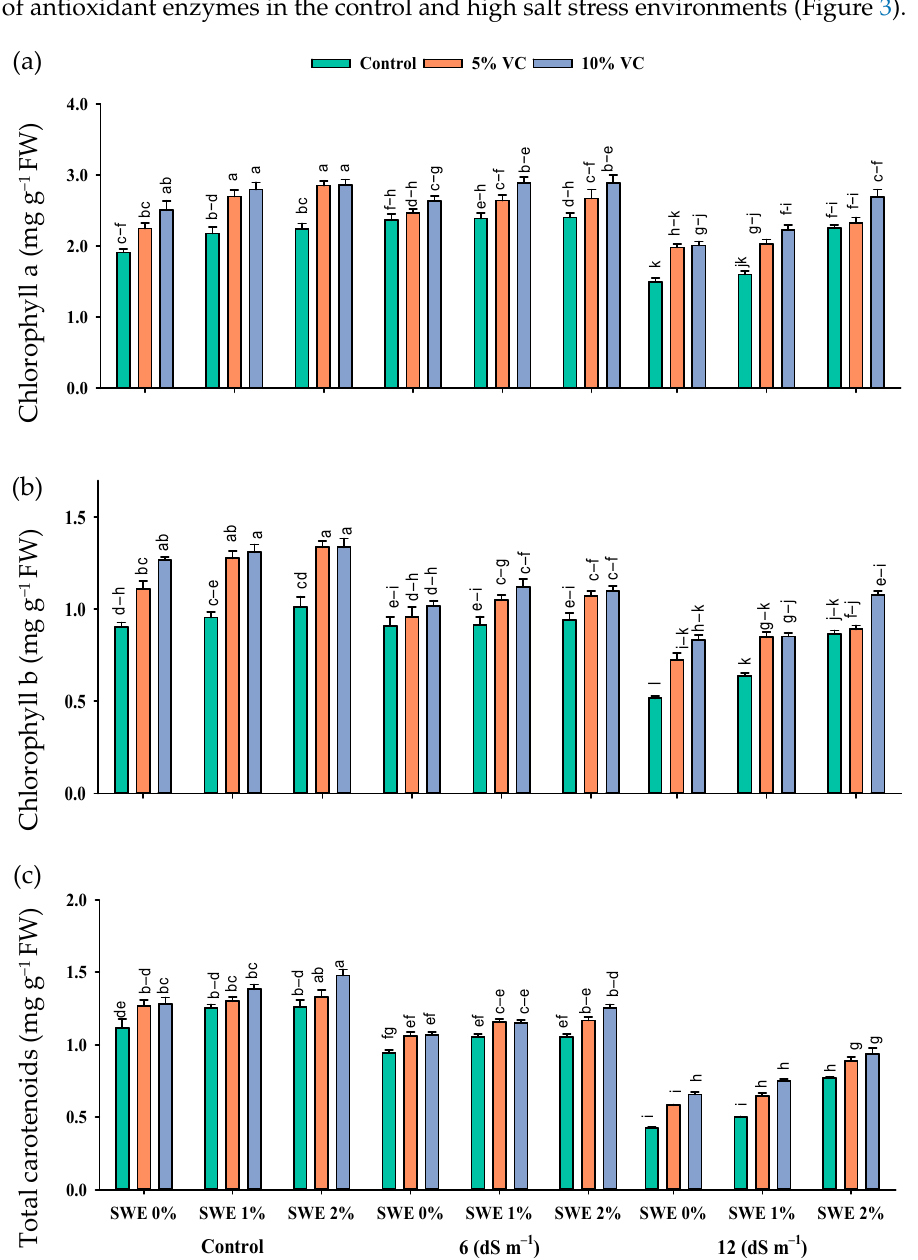
Figure 2. Chlorophyll a (mg g − 1 FW; a ), chlorophyll b (mg g − 1 FW; b ), and total carotenoids (mg g − 1 FW; c ) contents of maize as affected by various treatments of vermicompost (VC), sorghum water extract (SWE) under control, moderate salinity (6 dS m − 1 ), and high salinity (12 dS m − 1 ). Error bars depict the standard error of 3 replications ( n = 3). Bars with the same letters do not differ significantly ( p ≤ 0.05).